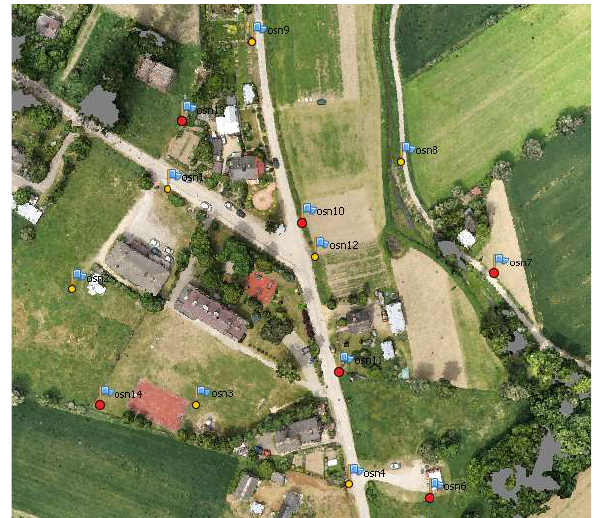
Figure 3. Distribution of the GCPs over the test area (yellow check points, green - control points)